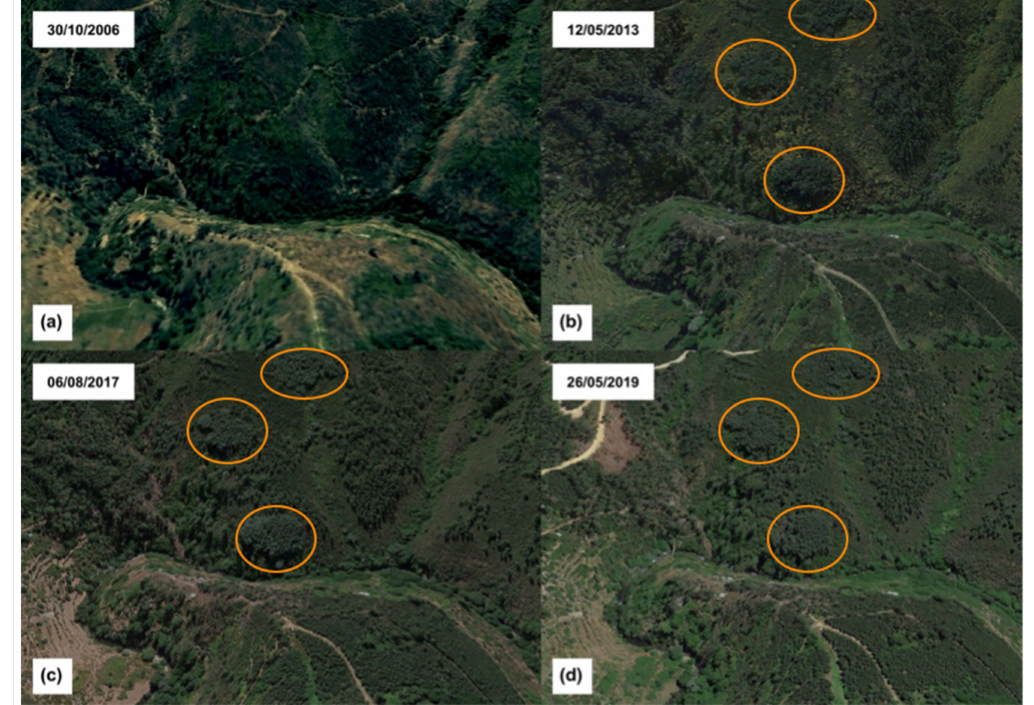
Figure 11. Sentinel-2 satellite images of the A. dealbata stands located on the opposite slope to the villages of Cabeça and Casal do Rei. ( a ) image obtained on 30 October 2006; ( b ) image obtained on 12 May 2013; ( c ) image on 6 August 2017; and, ( d ) image obtained on 26 May 2019. The observation positioning was chosen to reflect the same view used in the previous Figure